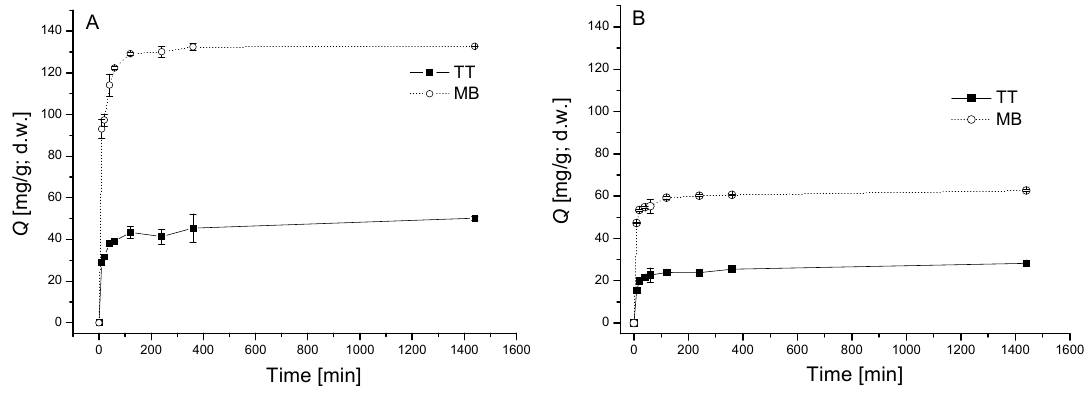
Figure 1. Kinetics of thioflavin T (TT) and methylene blue (MB) biosorption by dried biomass of moss V. dubyana ( C B = 0.5 g/L) from single ( A . C 0 TT = 40 mg/L or C 0 MB =80 mg/L) and binary ( B . C 0 TT = 40 mg/L and C 0 MB = 40 mg/L) solutions at 25 °C and pH 6.0. Error bars represent standard deviation of the mean (±SD, n = 2).